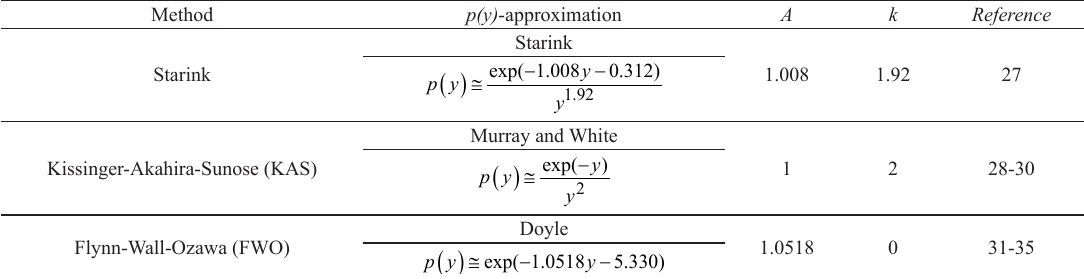
Table 1. Parameters A and k from Equation 8 for p(y) -isoconversion methods.